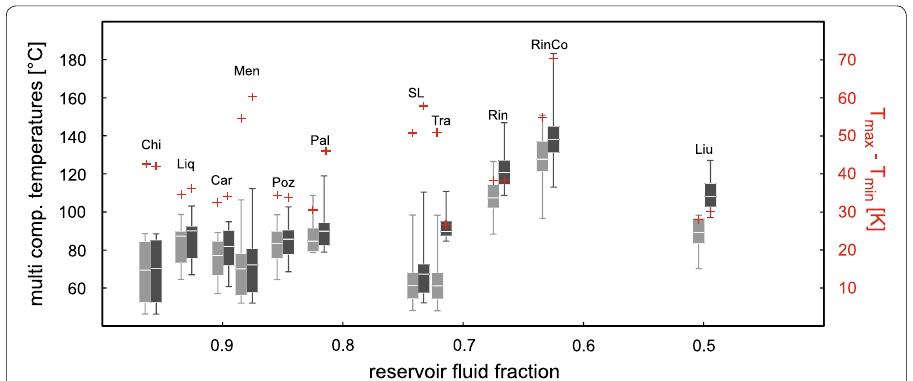
Fig. 5 Distribution of temperatures for the Villarrica springs calculated by multicomponent geothermometry for original sample compositions ( light grey ) and for dilution-corrected concentrations ( dark grey ) plotted versus degree of dilution. The spread of temperature ( T max T min ) is indicated by red −